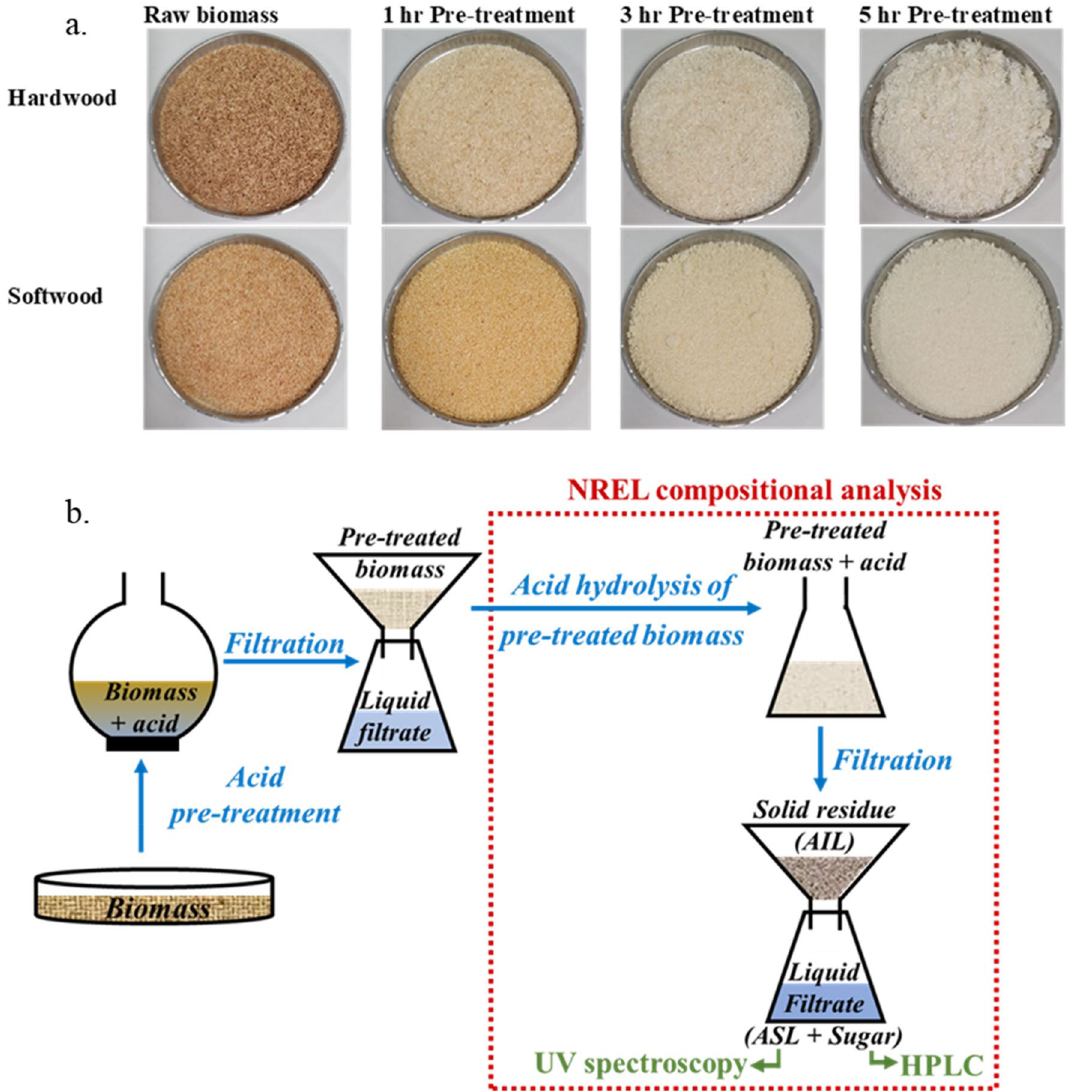
Figure 5. Color difference and physical appearance of untreated and acid pretreated biomass thermally-assisted pretreatment method using peracetic acid. Lower diagram shows a schematic of biomass pretreatment and NREL compositional analysis of the untreated and pretreated samples.